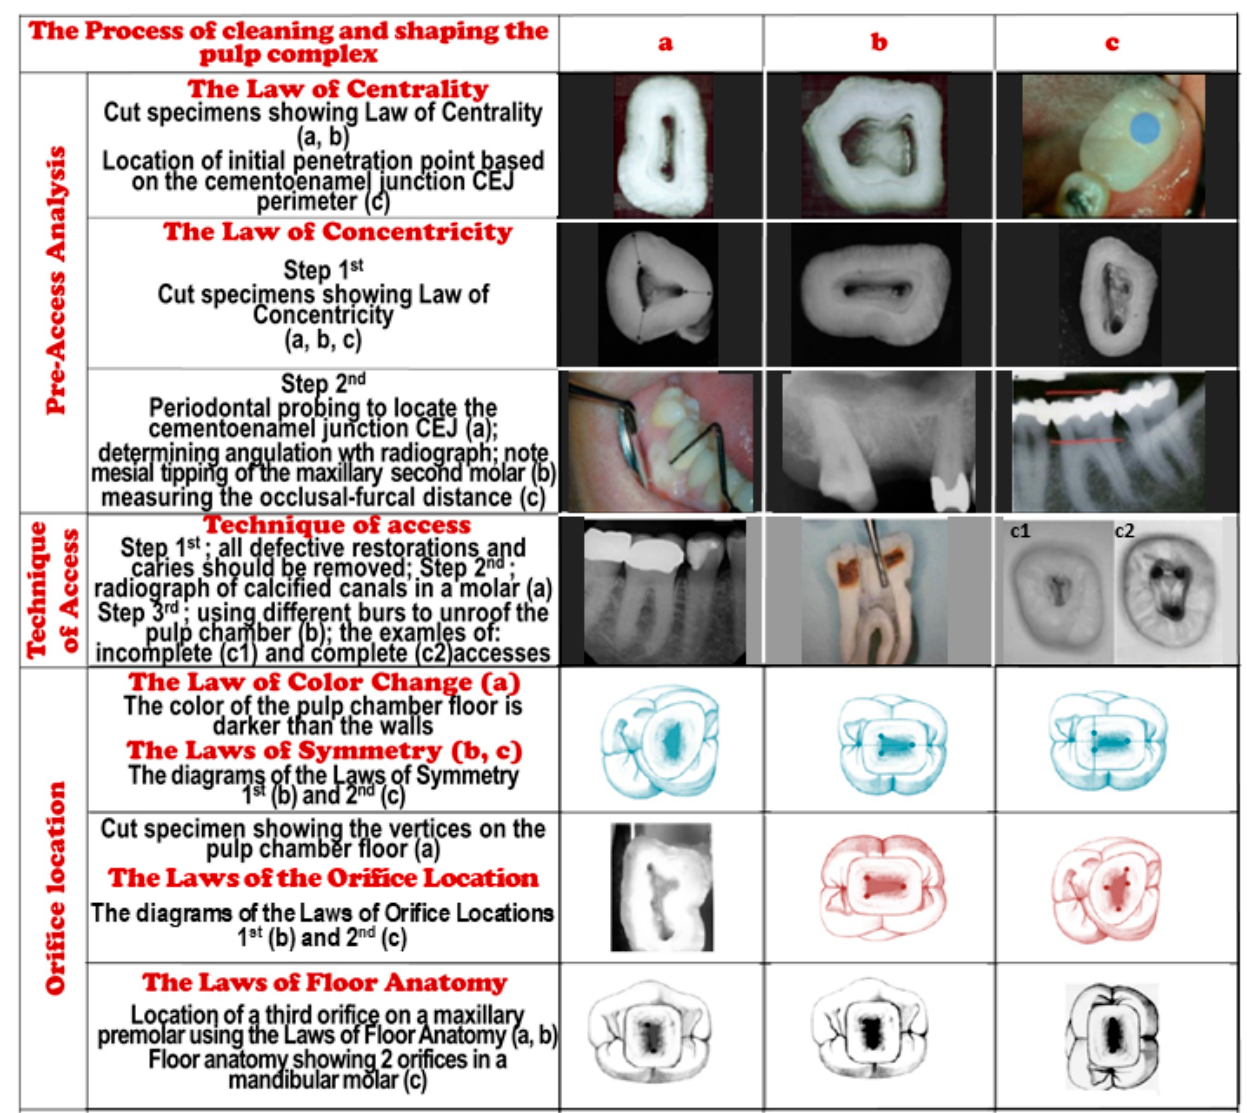
Figure 4. Diagram of the principles of tooth qualification for endodontic treatment based on the analysis of the anatomy of the treated tooth and the surrounding tissues; ( a – c ) show examples.